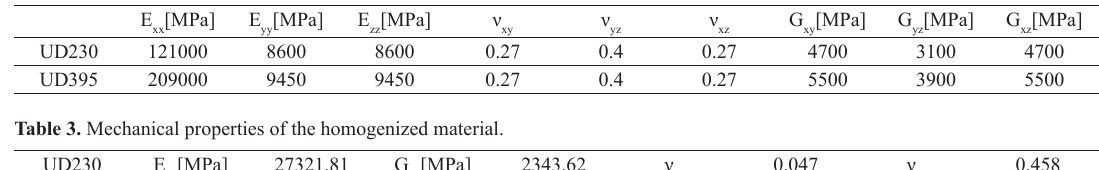
Table 2. Mechanical properties of the thread materials.